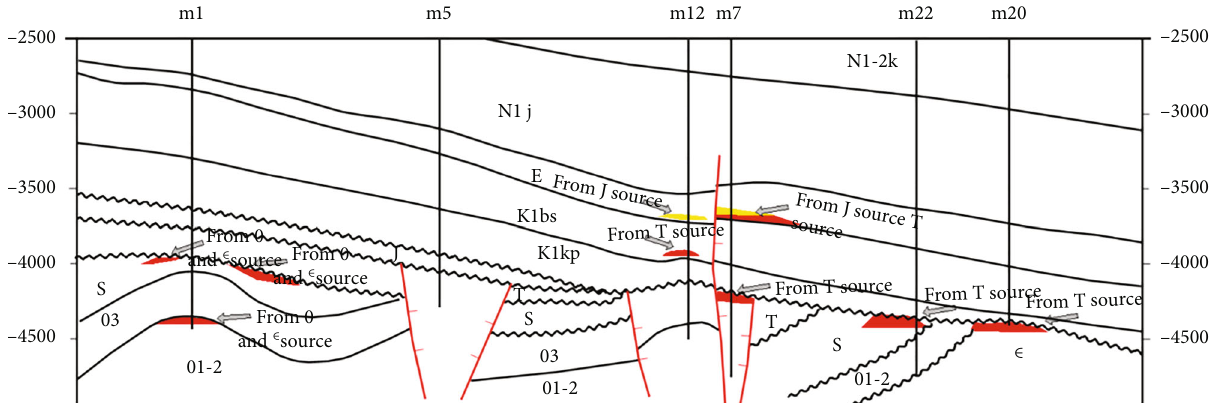
Figure 2: Vertical distribution of Jurassic and Triassic oil and gas in the western Tabei area. Table 1: Geochemical analysis of Paleogene and Cretaceous reservoirs in well M7. Comparison of crude oil biomarker compounds in the M7 well area